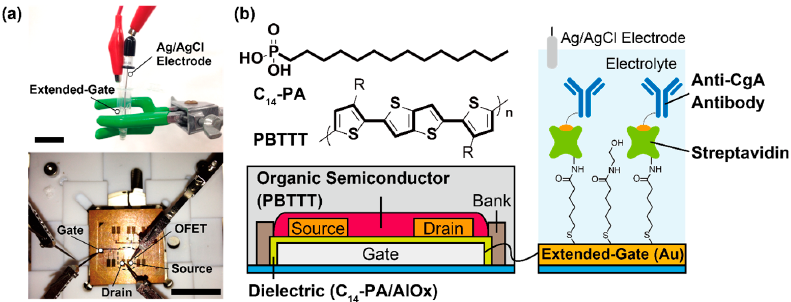
Figure 1. ( a ) Photograph of the fabricated device (above: the detection portion, below: the OFET). The scale bars are 2 cm; ( b ) Schematic illustration of the OFET-based immunosensor. For the label-free detection of hCgA, the modification scheme of the extended-gate electrode